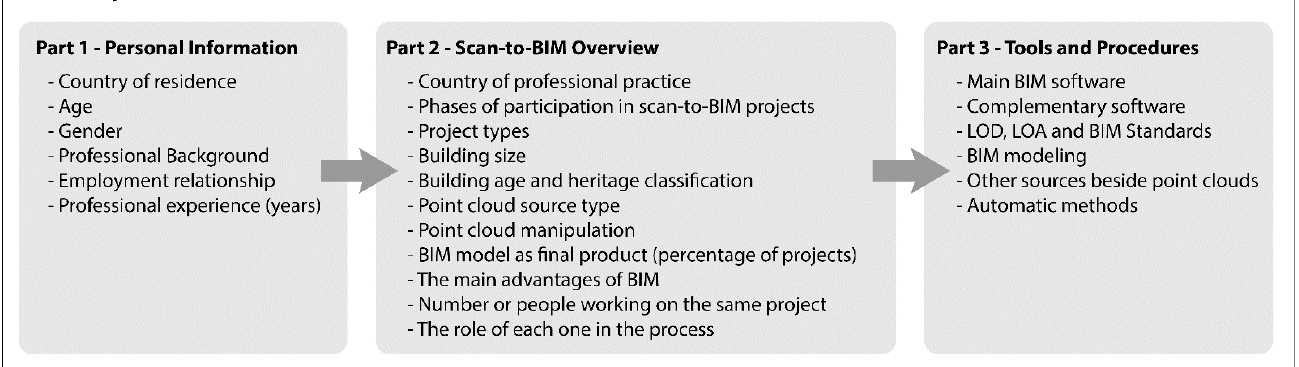
Figure 1. Survey structure, questionnaire sections, and contents.